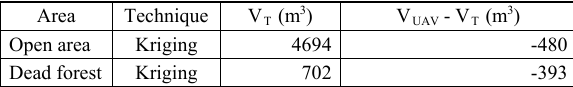
Table 6. UAV-based vs. interpolated snow tube volume at open and dead forest area.